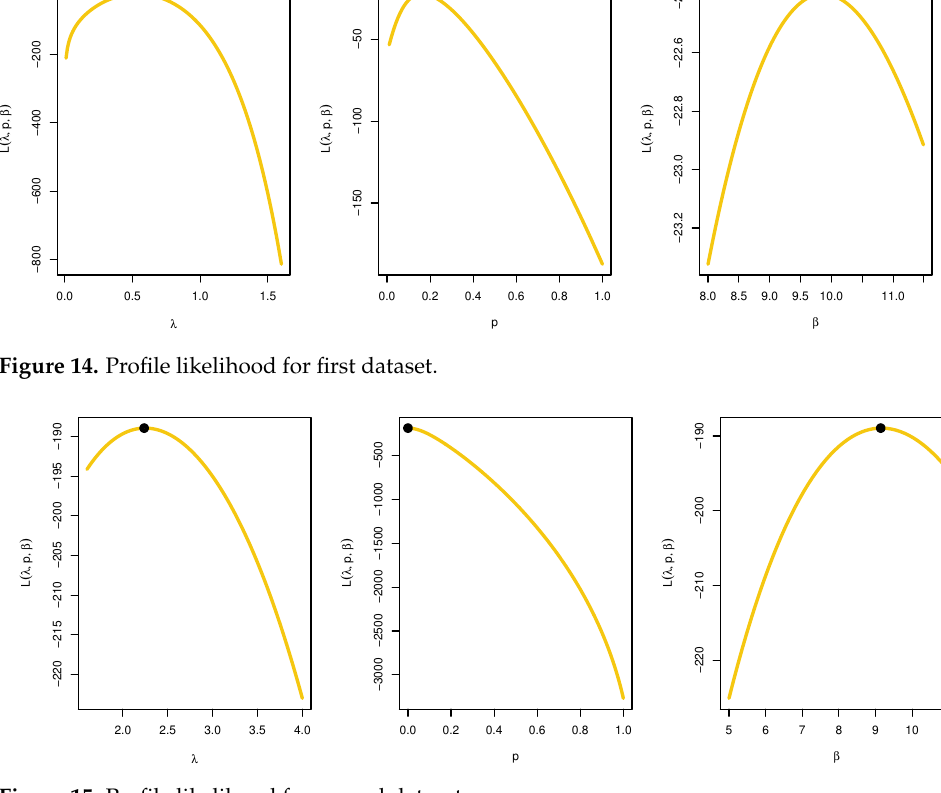
Figure 15. Profile likelihood for second